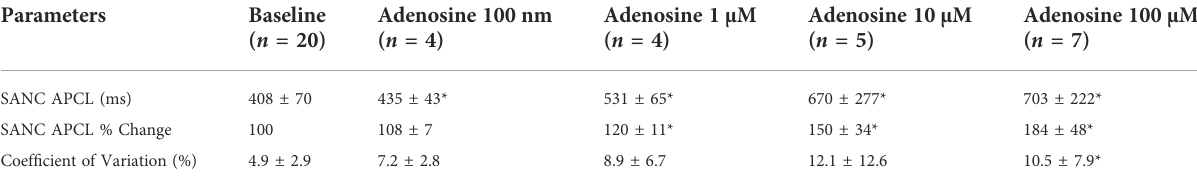
TABLE1AdenosineslowsSANC fi ringrateinadose-dependentmanner.Calciumsignalmeasurementsofrhythmically fi ringSANCweretakenbefore and after adenosine exposure. To minimize cell phototoxicity, different cells were used for each dose of adenosine. All SANC measured slowed down in response to adenosine. At each concentration of adenosine, the increase in APCL was signi fi cant ( p < 0.05).